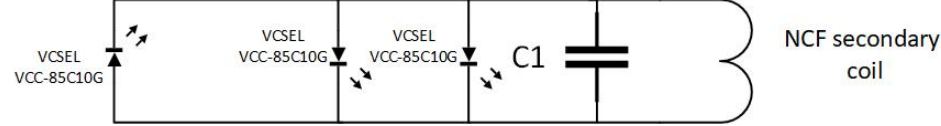
Figure 11. SCL simplified block diagram with the three functions for remote computation.